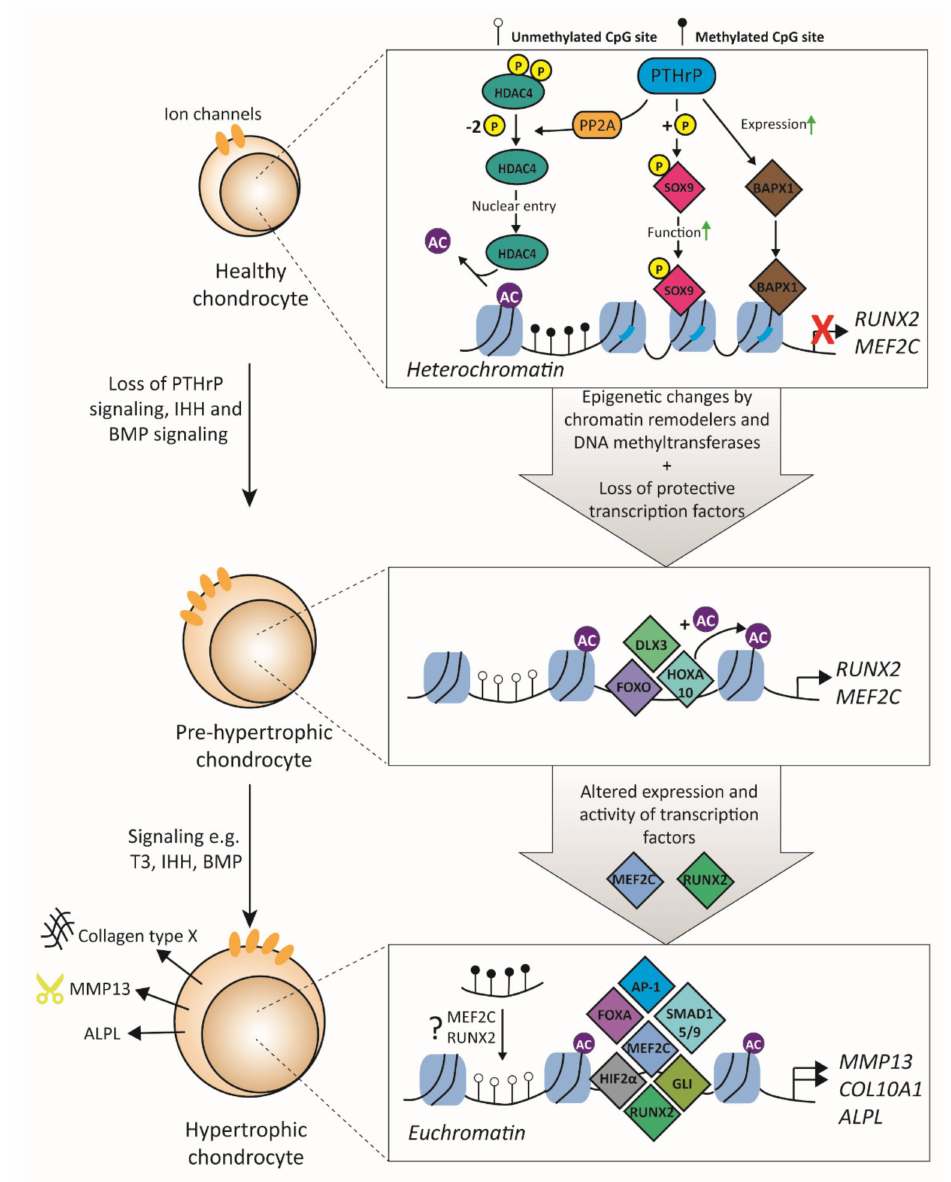
Figure 3. Transcription factors involved in chondrocyte hypertrophy. In a healthy chondrocyte, hypertrophy-related genes are silenced due to the compact composition of the nucleosomes and transcription factors that repress hypertrophy. PTHrP is a crucial signaling molecule that represses chondrocyte hypertrophy by increasing expression of BAPX-1, increasing SOX9 activity, and inducing nuclear translocation of HDAC4 to maintain hypoacetylation of the promoters of RUNX2 and MEF2C. In prehypertrophic chondrocytes, epigenetic changes occur by, e.g., loss of chromatin remodelers and loss of protective transcription factors against hypertrophy. This leads to increased chondrocyte volume and the opening of chromatin. TFs such as HOXA10, FOXO1, and DLX3 can bind in the promoter of RUNX2 and activate its transcription. RUNX2 and MEF2C are the MR of chondrocyte hypertrophy and regulate, in turn, with other transcription factors, the expression of hypertrophy makers such as COL10A1, MMP13, and ALPL. PTHrP = parathyroid hormone-like protein; SOX9 = SRY-BOX transcription factor 9; BAPX-1 = homeobox protein Nkx-3.2; HDAC4 = histone deacetylase 4; NF κ B = nuclear factor kappa B; RUNX2 = runt-related transcription factor 2; MEF2C = myocyte-specific enhancer factor 2C; AP-1 = activator protein 1; GLI = glioma-associated oncogene; FOXA = forkhead box transcription factor class A; HIF2 α = hypoxia-inducible factor 2-alpha; COL10A1 = collagen type X; MMP13 = matrix metalloproteinase 13; ALPL = alkaline